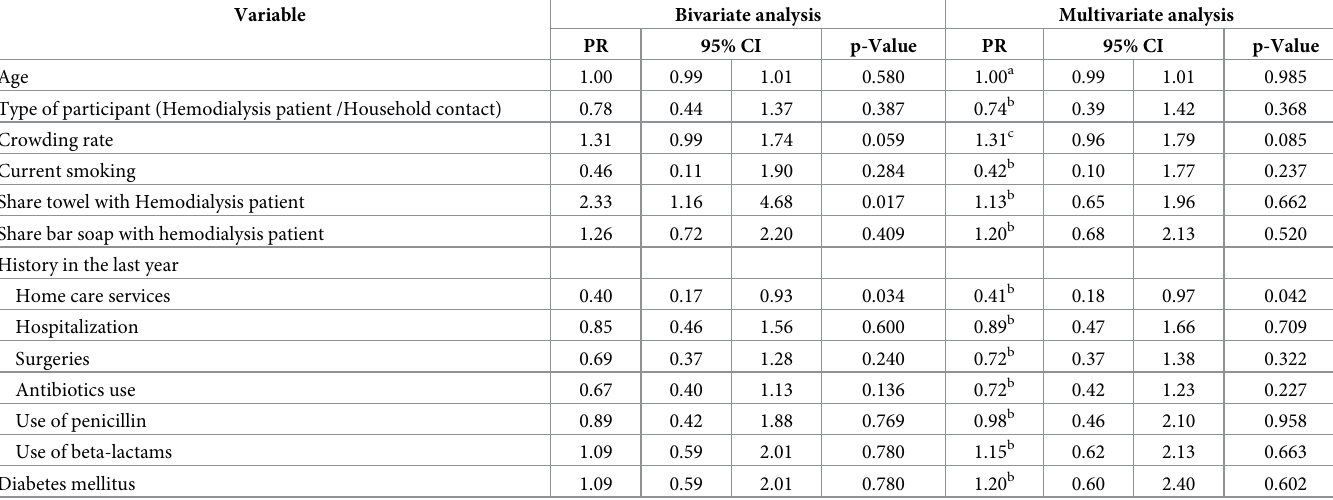
Table 2. Bivariate and multivariate analysis for identification of factors associated with colonization by S . aureus .